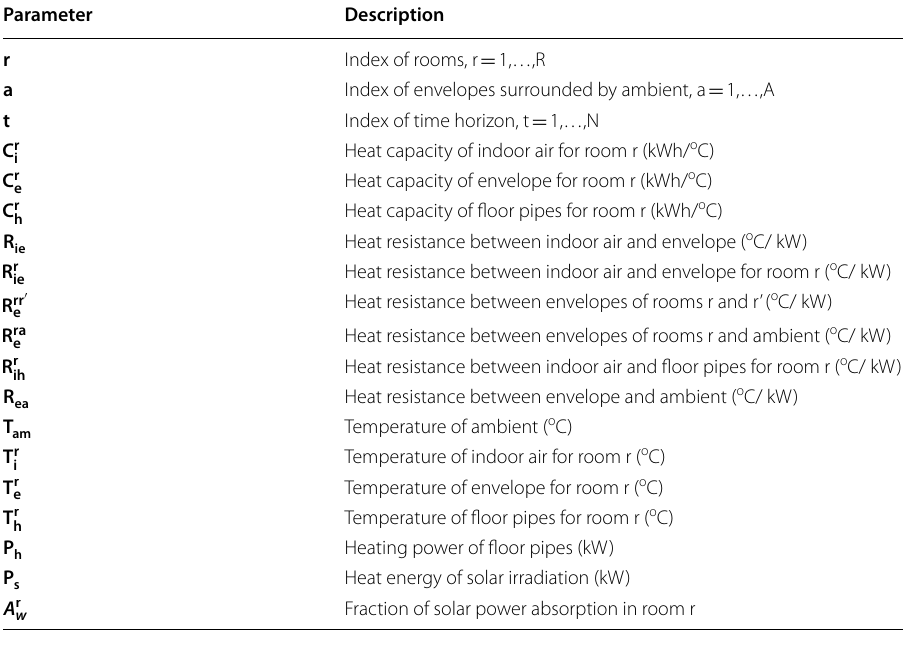
Table 1 Description of parameters and variables of the thermal dynamic model Parameter